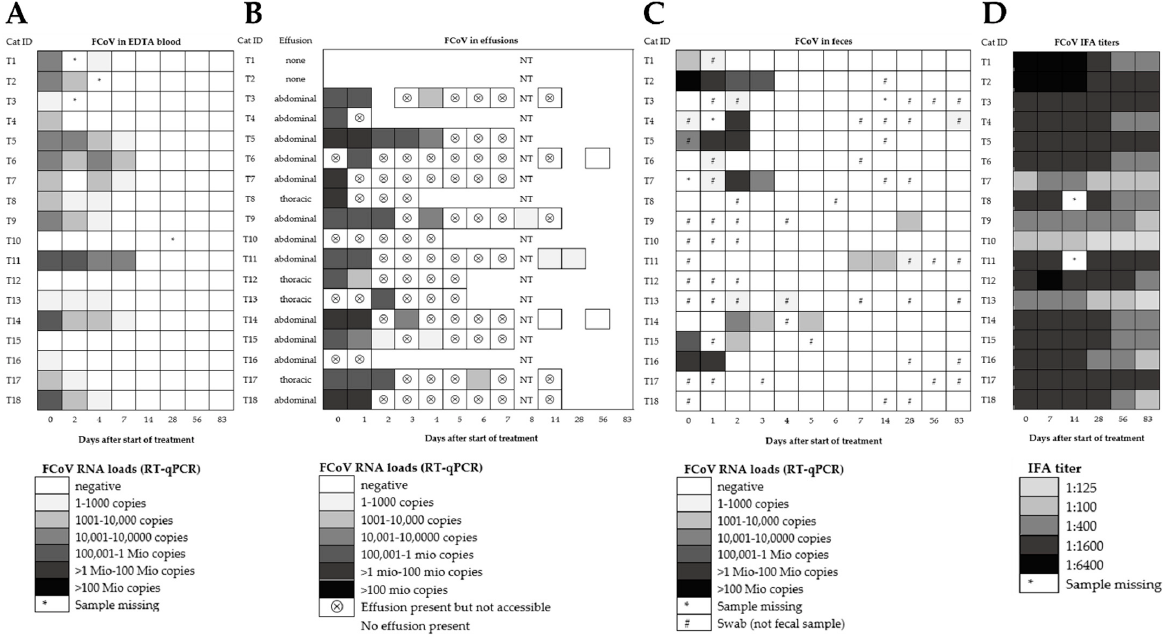
Figure 1. Feline coronavirus (FCoV) viral RNA loads in different compartments and anti-FCoV titers of treated FIP cats (adapted from [43]). ( A ) EDTA anti-coagulated blood; ( B ) Effusions; ( C ) Voided fecal samples or fecal swabs; and ( D ) Antibody titers. FCoV RNA loads were determined by quantitative reverse transcription polymerase chain reaction (RT-qPCR) ( A – C ). Antibody titers were determined by indirect immunofluorescence assay (IFA). NT, not